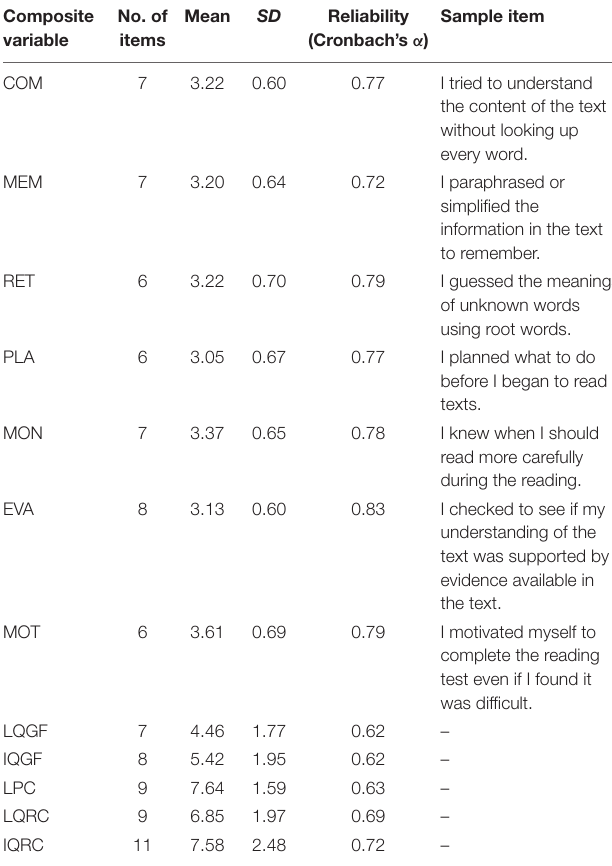
TABLE 1 | Means, standard deviations, internal reliability, and sample items for composite variables ( N = 547).